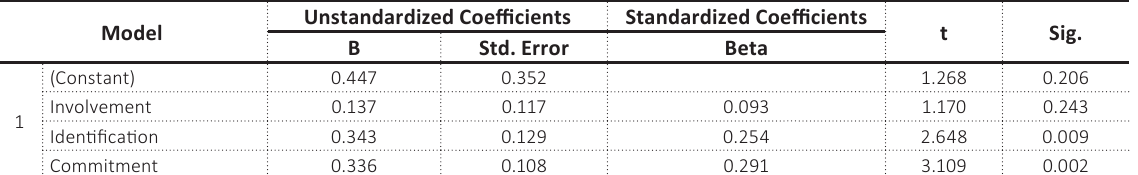
Table 7. Customer loyalty and customer behavior